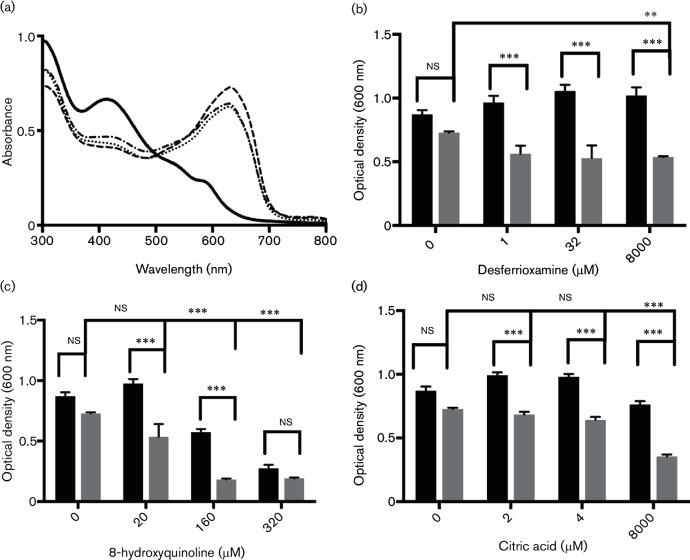
[Mn(CO)3(tpa-κ3N)]Br exacerbates growth inhibition in iron-restricted medium and triggers production of siderophore-like activity. (a) Culture supernatants were treated either with (solid line) or without (dot-dashed line) the PhotoCORM (300 µM) before pre-illumination at 365 nm for 6 min. Additional controls are the PhotoCORM (300 µM) illuminated in Tris-HCl buffer (dotted line) and Tris-HCl buffer only (dashed line). Samples were treated with CAS assay solution and the absorbance spectra recorded; decreased A630 nm indicates iron loss from CAS due to chelation by the sample. (b)–(d) Culture aliquots were shaken in a 96-well plate and supplemented with: (b) desferrioxamine; (c) 8-hydroxyquinoline; and (d) citric acid. The graphs show the OD600 at 24 h. Black bars represent no PhotoCORM and the grey bars represent the addition of activated PhotoCORM (150 µM). The bars are the mean±SEM of three biological repeats. *, P<0.05; **, P<0.01; ***, P<0.001 (two-way ANOVA).